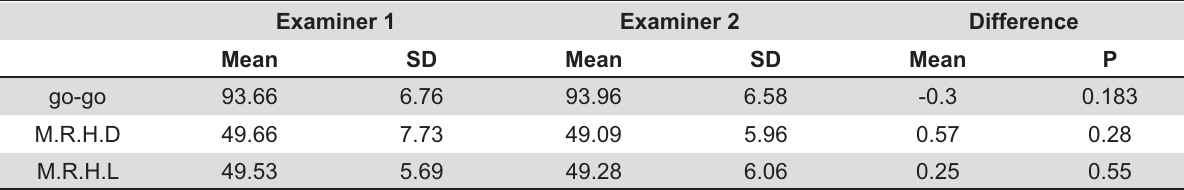
Legend: go-go=Bigonial diameter; M.R.H.D=Ramus height right; M.R.H.E=Ramus height left Table 3- Logistic discriminant analysis: method of Oliveira, et al. 15 (1995) Model Sex=M.R.H *